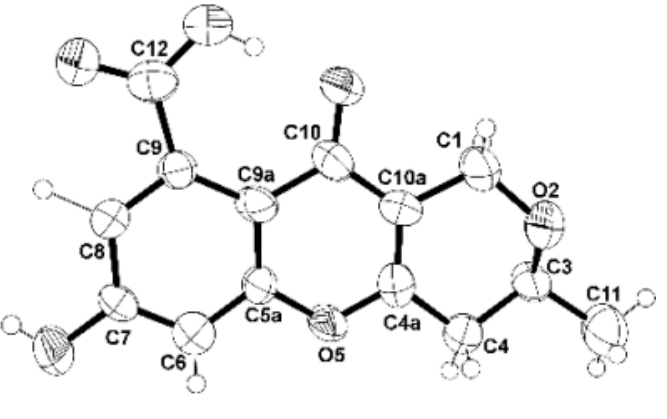
Figure 2. Ortep view of 1 .